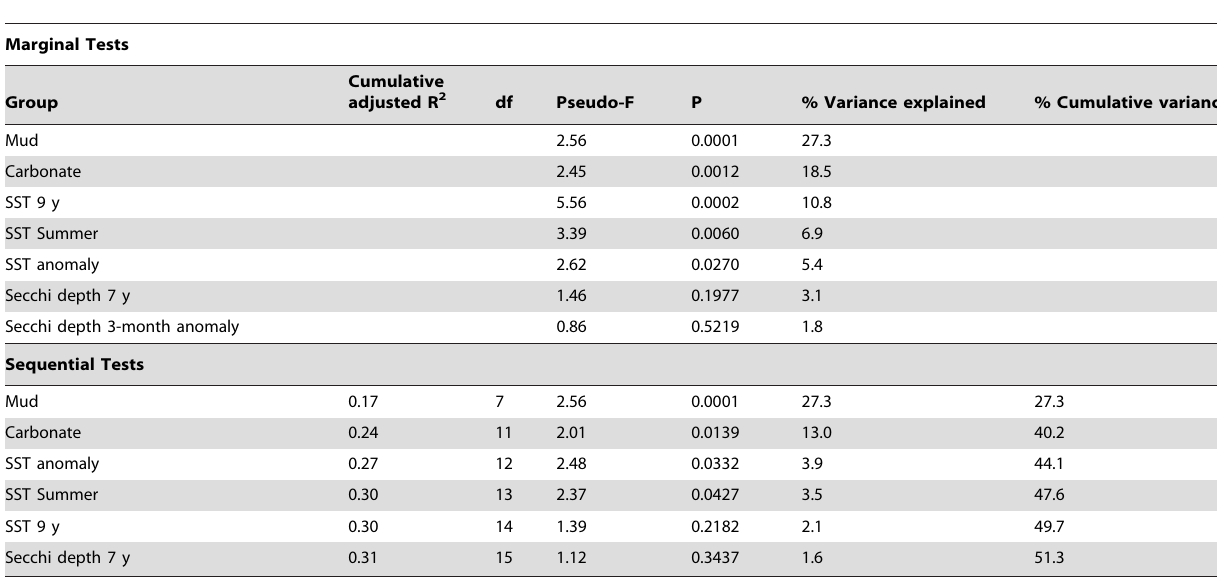
Table 2. Summary of regional-scale analyses for model selection to examine the relationship between Symbiodinium communities and environmental variables.